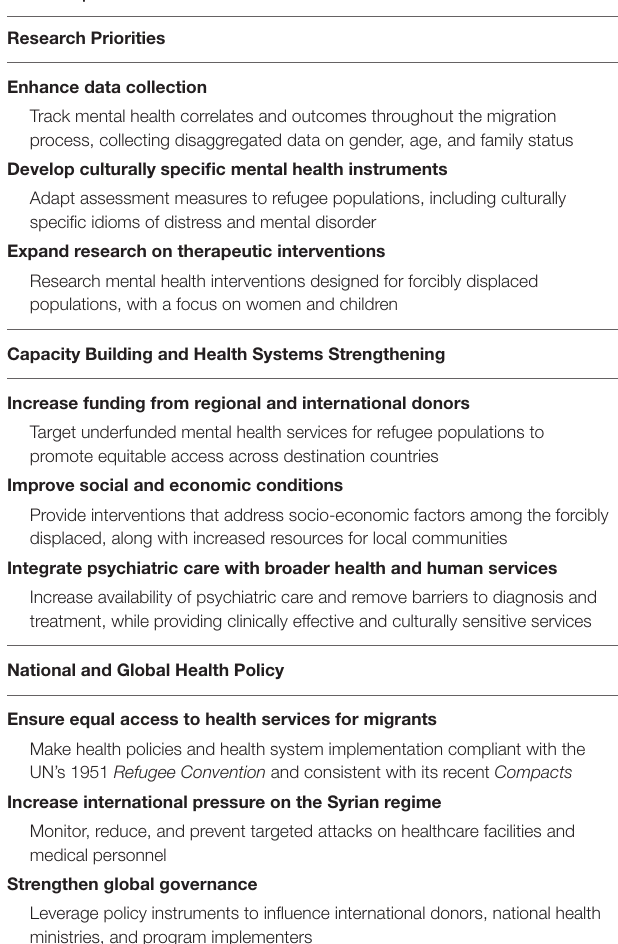
TABLE 4 | General